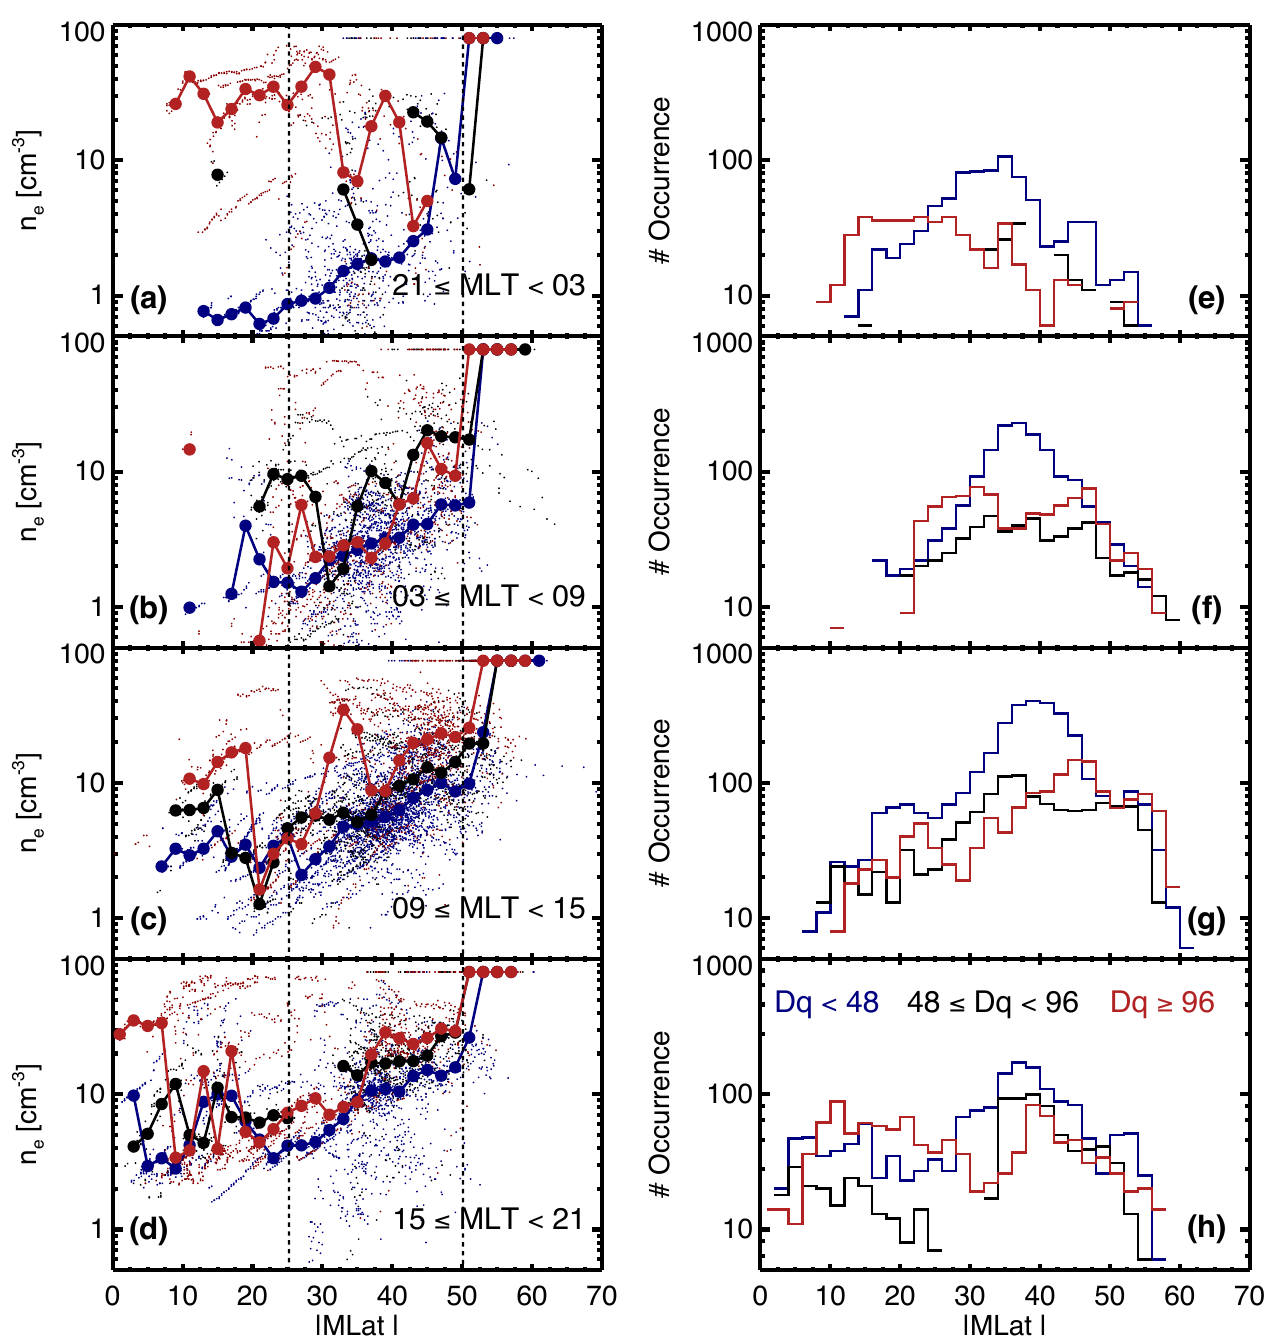
Fig. 8. Same as Fig. 7a (left column) and Fig. 7c (right column), but for field lines at higher L -values, 7 . 5 ≤ L < 8 . 5. Scatter plot (left) and occurrence numbers (right) are split in four MLT sectors, as in Fig. 6: 21:00–03:00MLT (panels a and e ), 03:00–09:00MLT (panels b and f ), 09:00–15:00MLT (panels c and g ) and 15:00–21:00MLT (panels d and h ).